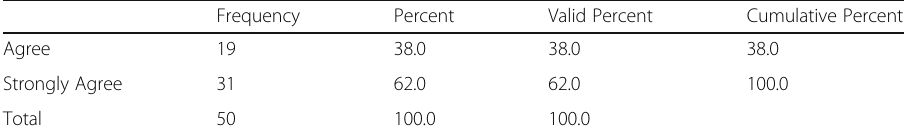
Table 12 Attitude towards using gamification frequency